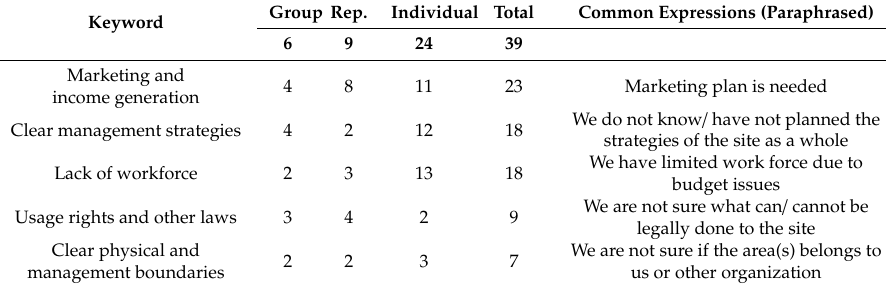
Table 2. Policy-related theme from the